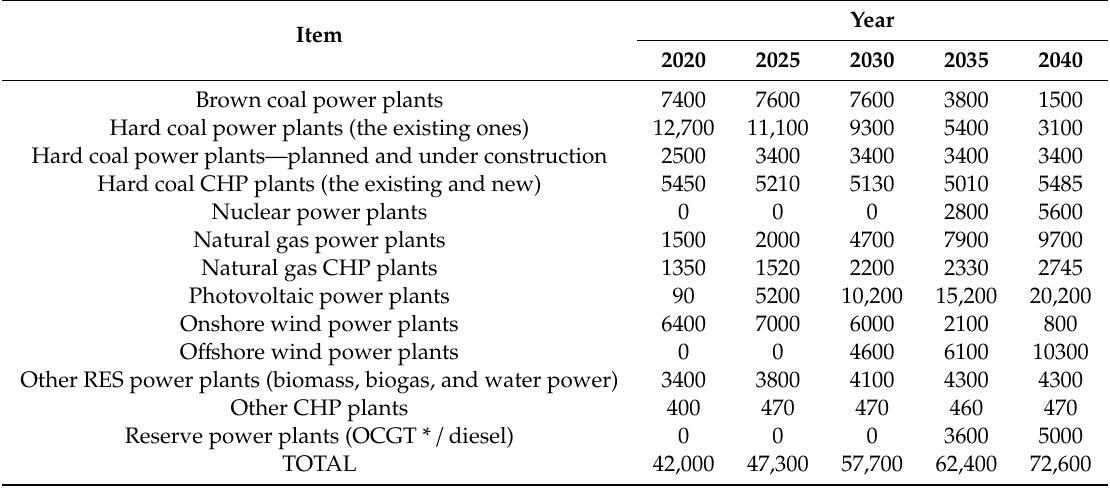
Table 6. The forecast of the net installed capacity, broken down by the technology used, until 2040, MW 1